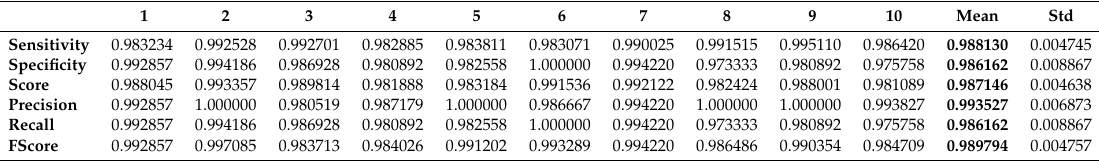
Table 7. All the iteration results for the 10 cross validation steps using the proposal combination of VAE for data augmentation and a CNN for the classification step on pathologies dataset. 1 2 3 4 5 Mean Std